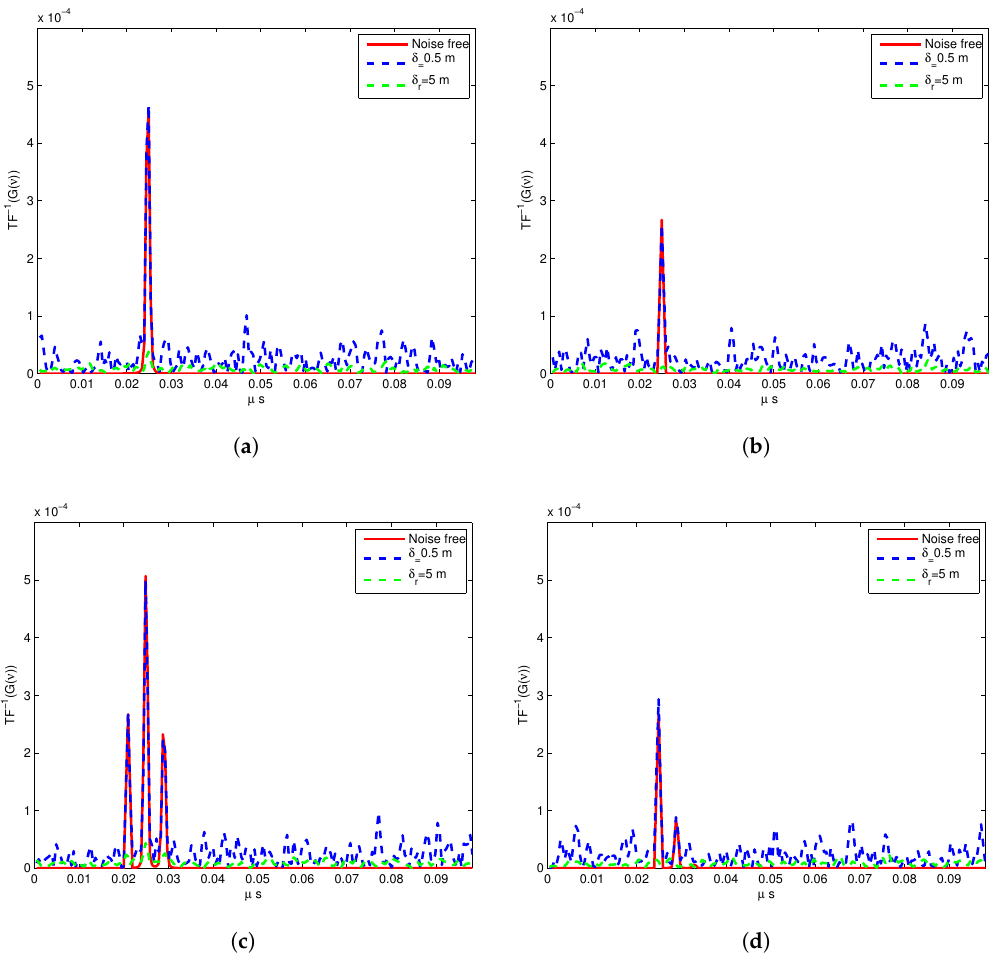
Figure 6. Example of inverse Fourier transform of G ( ν ) for f c = 0.1 GHz, d = 3000 m, h S = 3 m for h r = 1000 m, HH ( a ) and VV ( b ) and h r = 300 m HH ( c ) and VV ( d